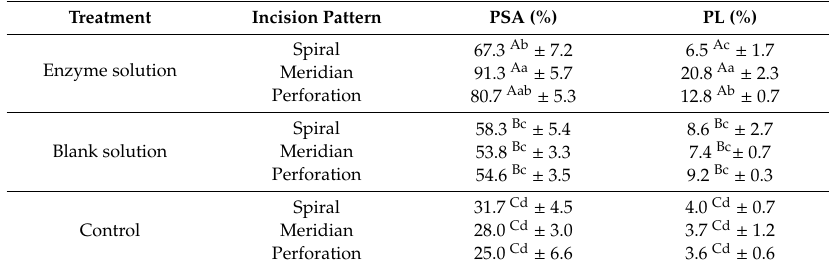
Table 1. Peeled surface area (PSA) and peel loss (PL) of cassava tubers by di ff erent incision patterns (spiral, meridian and perforation) after mechanical